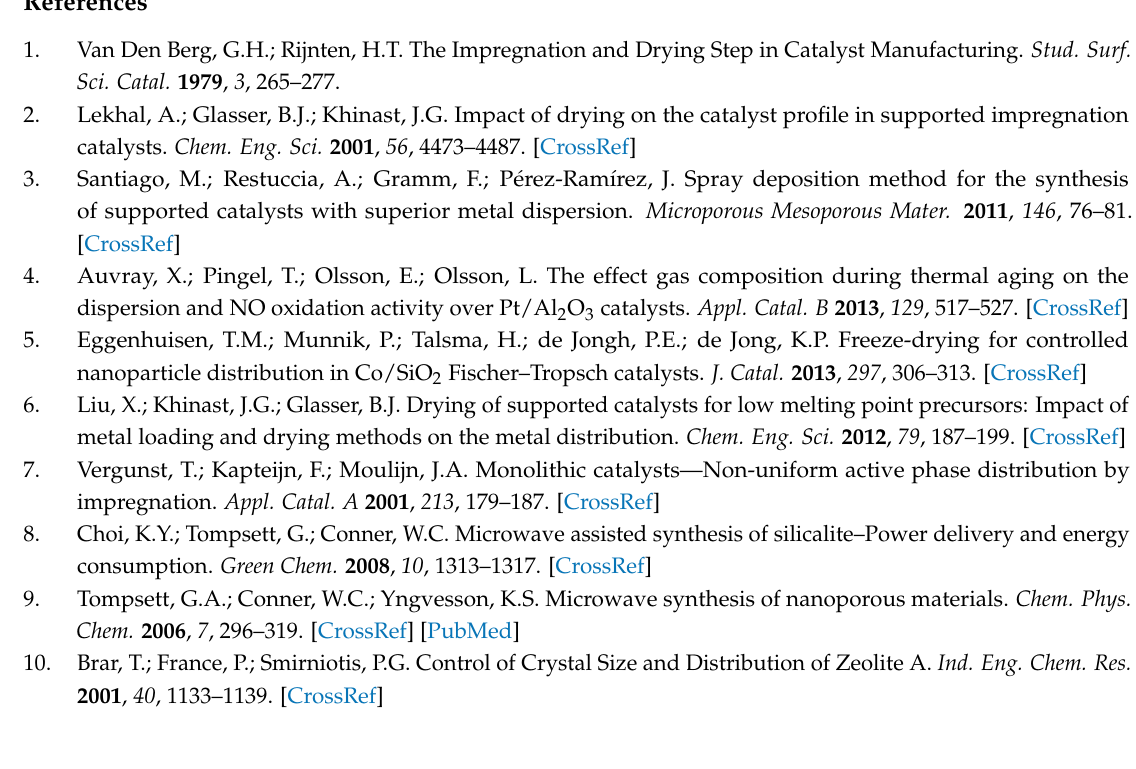
Figure S1: Description of the single-mode microwave apparatus (Sairem). Figure S2: Example of a typical CO adsorption isotherm: 1st isotherm corresponds to both physisorbed and chemisorbed CO, 2nd isotherm, measured after evacuation, corresponds to physisorbed CO and the difference corresponds, therefore, to the amount of chemisorbed